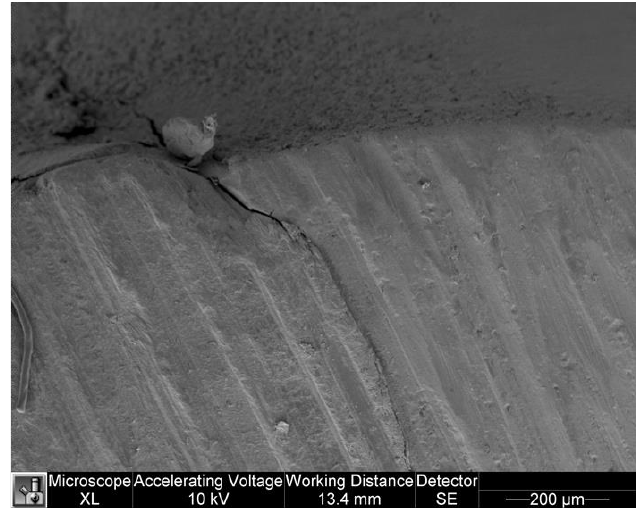
Figure 10. Overhang in a specimen of the control group.